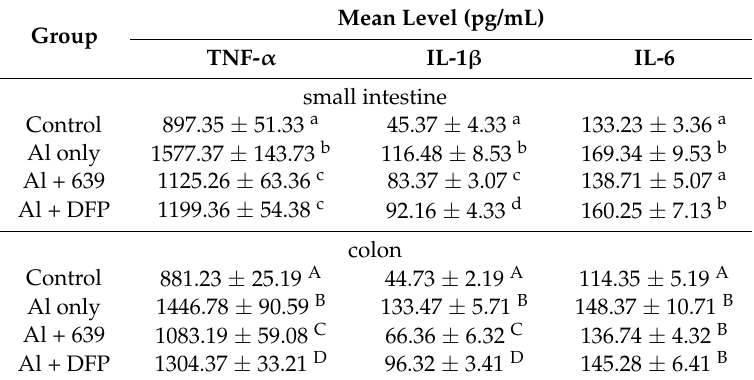
Table 3. The effects of L. plantarum CCFM639 on Al-induced alterations of cytokines in small intestine and